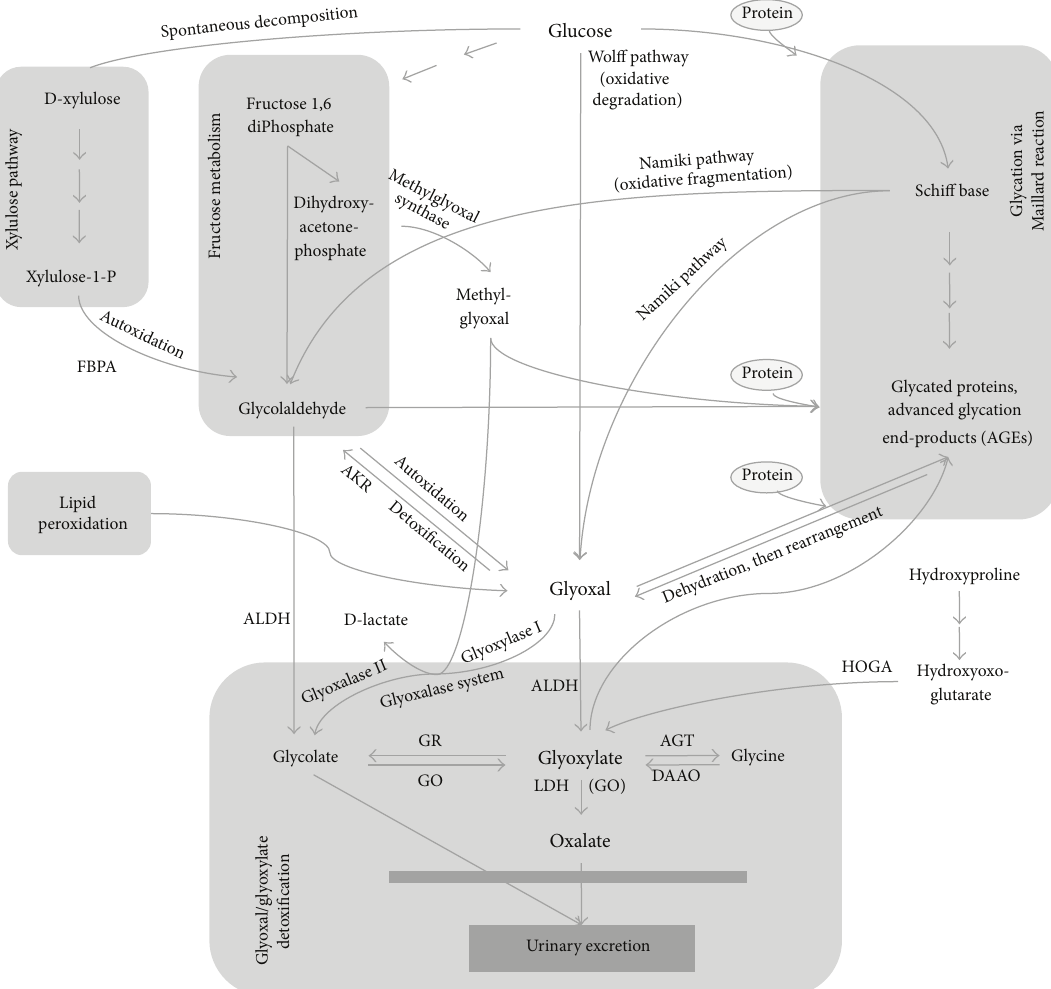
Figure 4: Glyoxylate biochemical pathways for mammals. AGT: alanine-glyoxylate aminotransferase; AKR: aldo-keto reductase; ALDH: aldehyde dehydrogenase; DAAO: D-amino acid oxidase; FBPA: fructose-bisphosphate aldolase; GO: glycolate oxidase; GR: glyoxylate reductase; HOGA: 4-hydroxy-2-oxoglutarate aldolase; LDH: lactate dehydrogenase; PFK: